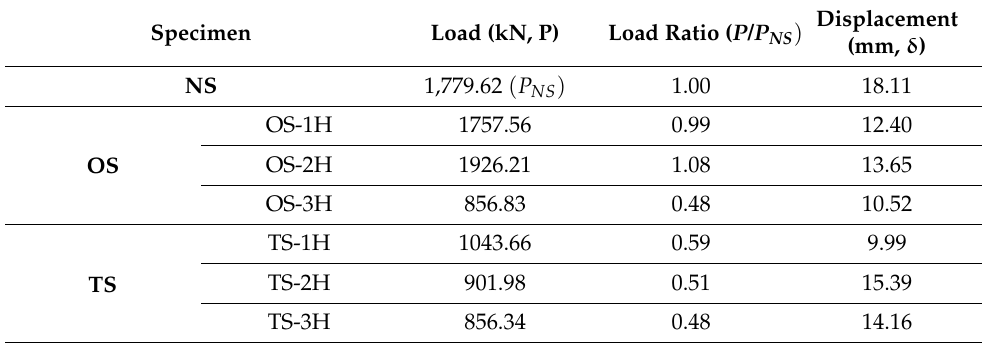
Table 11. Result of